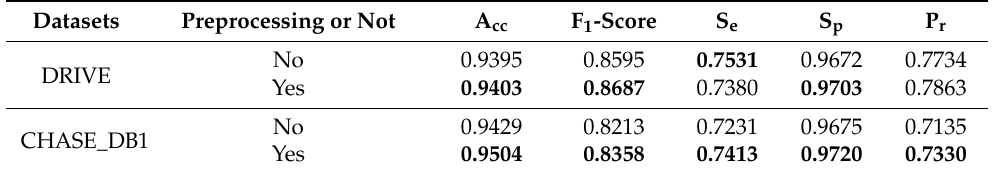
Table 2. Effect of preprocessing on experimental data.